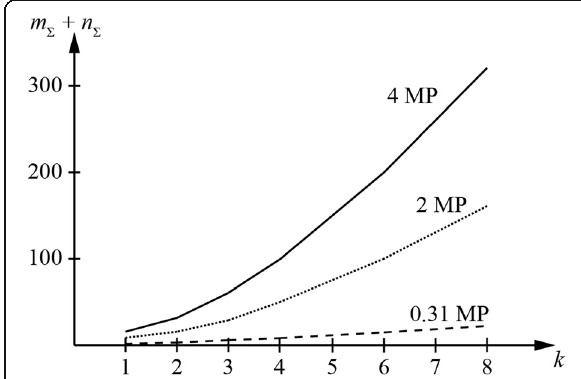
Fig. 2 Virtual pixel size of photosensitive RCDOER-matrix with different physical pixel